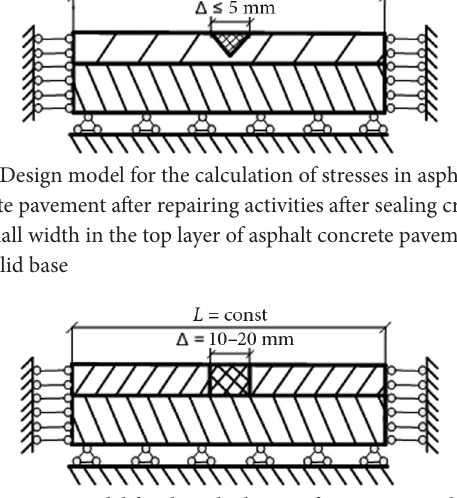
Fig. 7. Design model for the calculation of stresses in asphalt concrete pavement after repairing activities after milling and sealing a crack in asphalt concrete layer on a solid basis